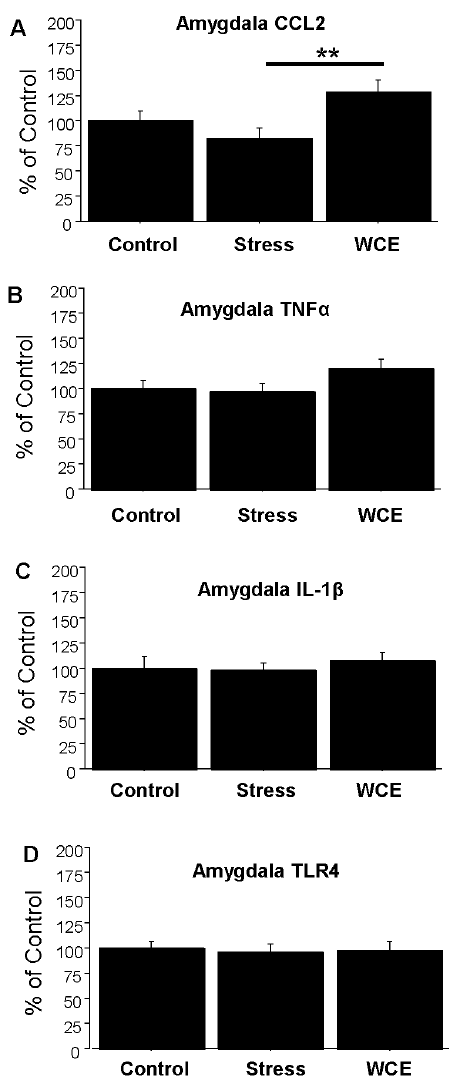
Figure 6. Effects of restraint stress or WCE on amygdala neuroimmune mRNAs. For CCL2, there was a modest, but significant, overall effect of treatments ( F (2,27) = 4.450, p < 0.05) with a significant group difference between WCE and stress. There were no other effects of treatments for TNF α , IL-1 β , or TLR4 mRNAs. ** p < 0.01 compared with the stressed group. A , B , C , and D delineate data for CCL2, TNF α , IL-1 β and TLR4 mRNAs, respectively, ( n = 7–11 per group).